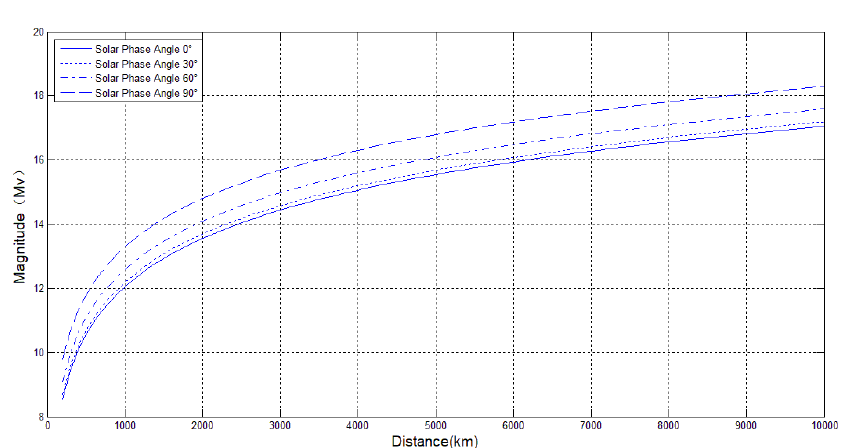
Figure 2. Relationship between detection capability and observation system.